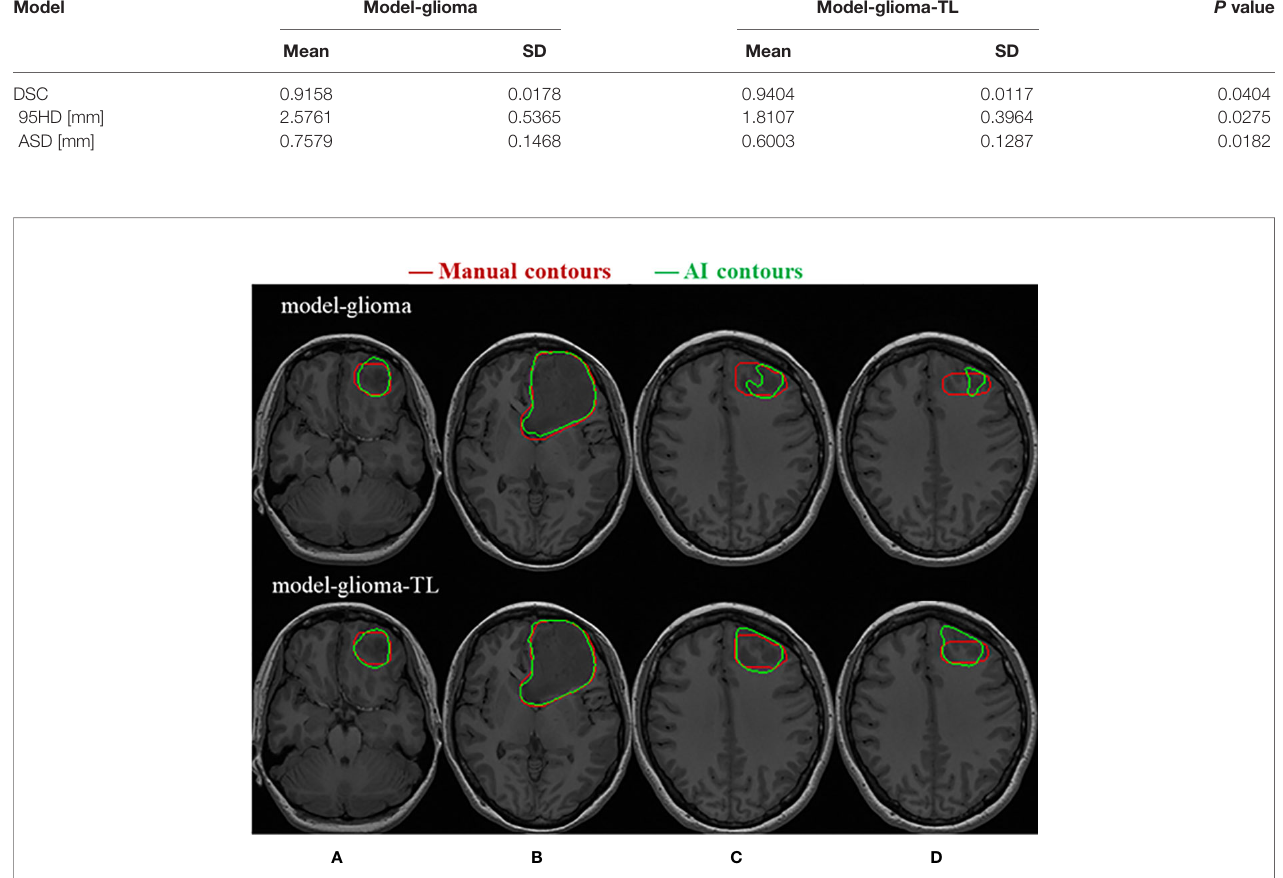
FIGURE 5 | Visualization of the test samples for the two models. The performance of model-glioma-TL was superior to that of model-glioma in the autosegmentation of glioblastoma GTVs, especially in the recognition of the small GTV in the upper and lower MRI slices (A, D) and the boundary delineation of the GTV contours in the intermediate MRI slices (B, C)